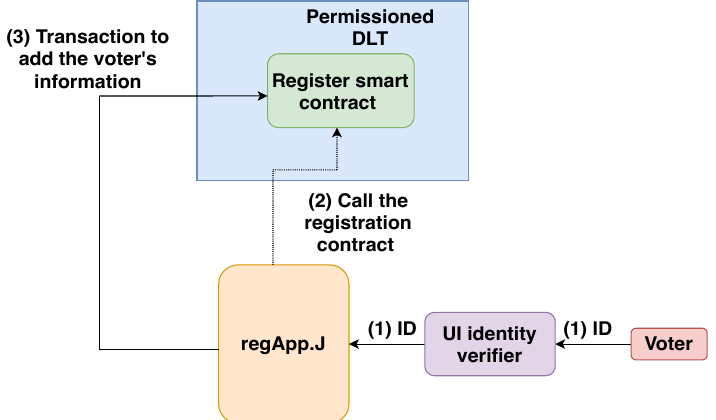
Figure 7. The voter-registration phase is managed by the TTP by making use of a permissoned DLT and smart